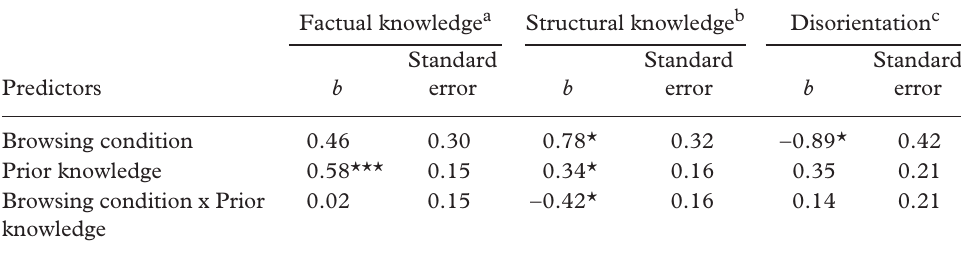
Table 2. Dependent variables as functions of the experimental factor and of the learner variable prior knowledge (linear